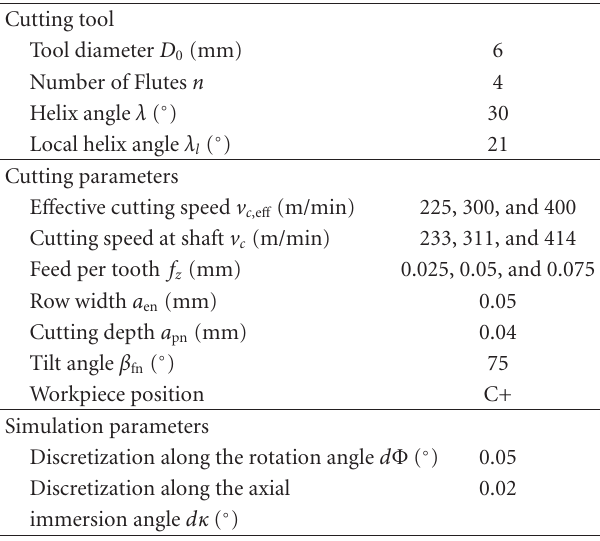
Table 4: Simulation input